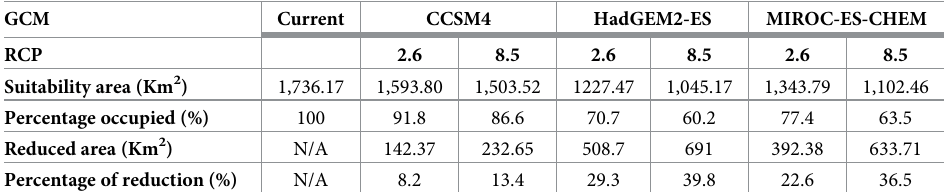
Table 3. Comparison between the suitability areas estimated by the current and future different general circula- tion models (GCM) for two Relative Concentration Pathways (RCP’s) used for 2050. GCM